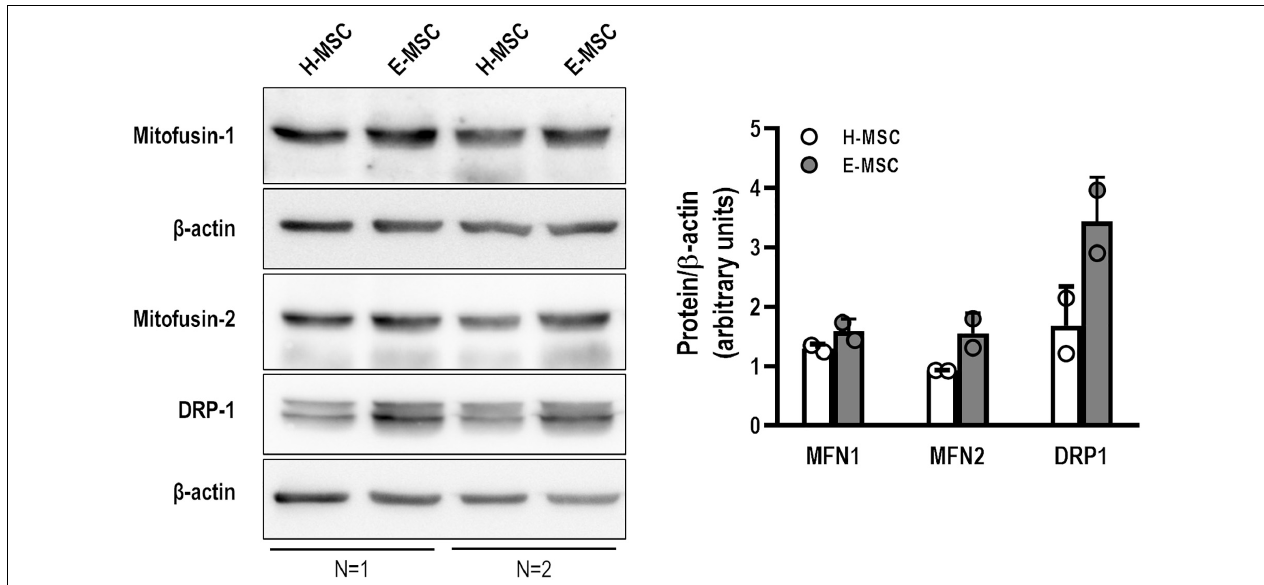
FIGURE 4 | Representative immunoblotting showing mitofusin-1 (MFN1), mitofusin-2 (MNF2), dynamin-related protein 1 (DRP1), and β -actin in MSCs from health (H) and emphysematous (E) donors. Data are expressed (right panel) as the ratio between protein expression and β -actin obtained by densitometry of 2 samples in each group.